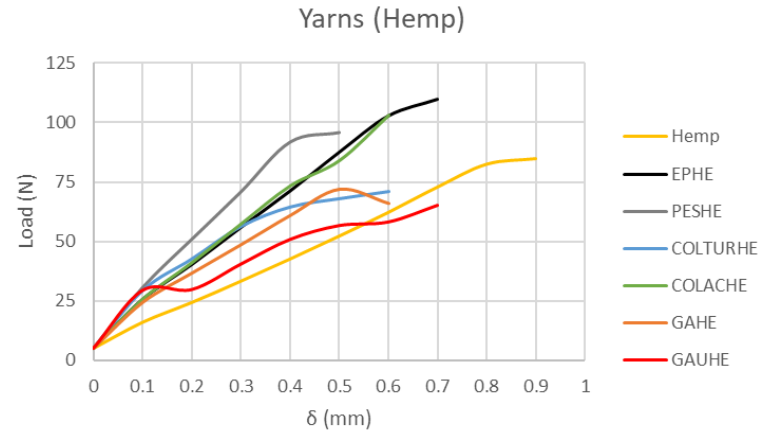
Figure 4. Load – extensometer curves for cotton yarns.